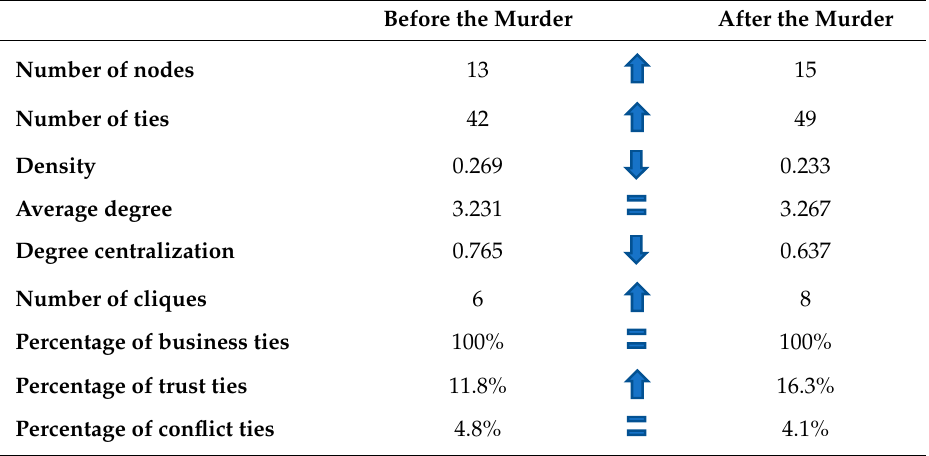
Table 1. Comparison of network structures before and after the Surrey Six Murder. Before the Murder After the Murder